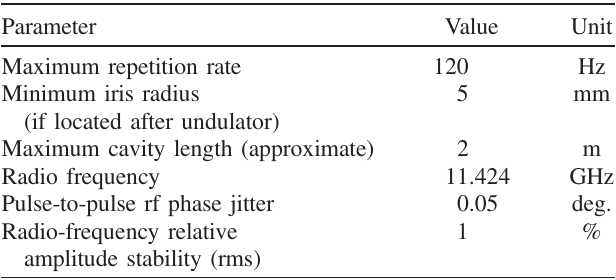
TABLE II. Approximate specifications for an X -band rf deflecting cavity (Table 3 from